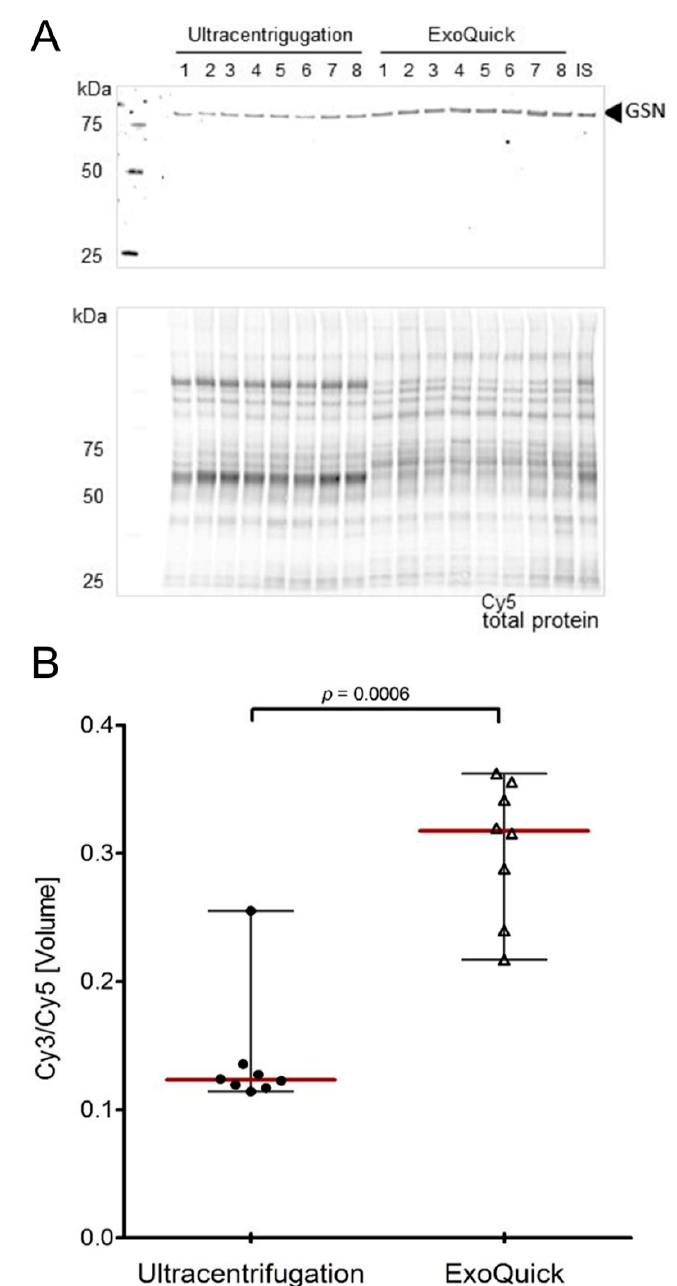
Figure 4. Multiplex fluorescent-based Western blot analysis of EVs isolated with ultracentrifugation and ExoQuick ™ . Specific antibody-targeted protein bands of Gelsolin were detected by Cy3-labeled secondary antibody ( A ). Cy5 total protein signals within each lane were used for normalization (Cy3 / Cy5 ratio). Based on an internal standard (IS), adjusted relative protein level calculation and statistical analysis were performed ( B ).